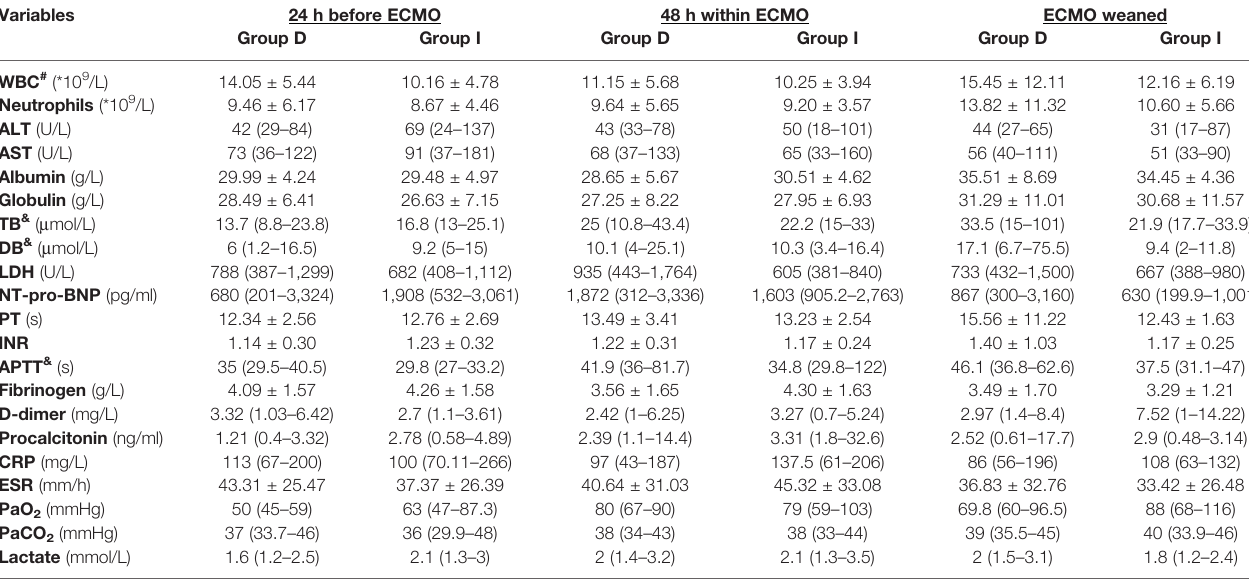
TABLE 2 | Comparison of laboratory examinations at three different time points.